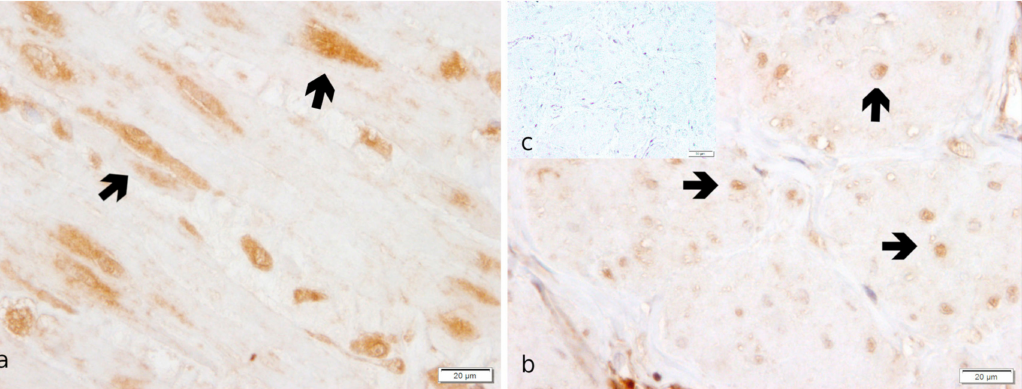
Figure 3. OXTR protein localization as revealed by IHC staining in canine uterine interplacental tissue. ( a ) myometrium, circular layer; ( b ) myometrium, longitudinal layer; ( c ) isotype control for OXTR given as inset. Independent of groups, myocytes ( (cid:212) black bold arrow) stained significantly stronger in the circular myometrial layer compared to the longitudinal one.